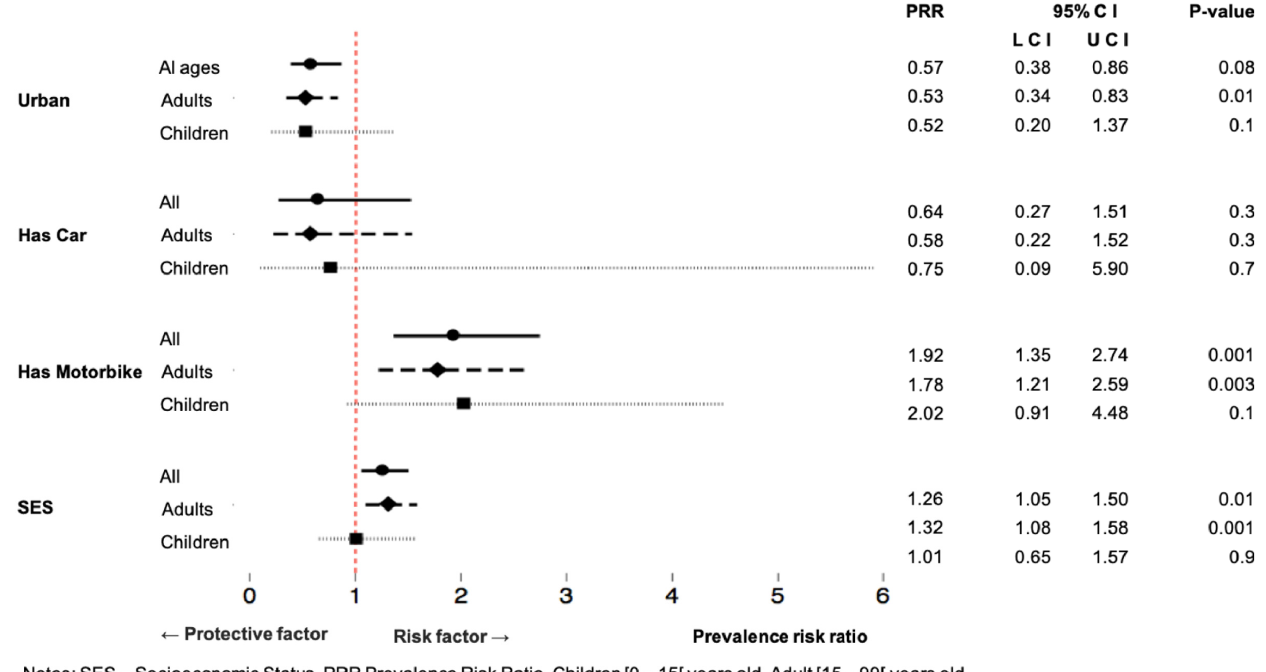
Fig 1. Prevalence risk ratio of having someone in the household injured by a road traffic injury in the last 6 months.